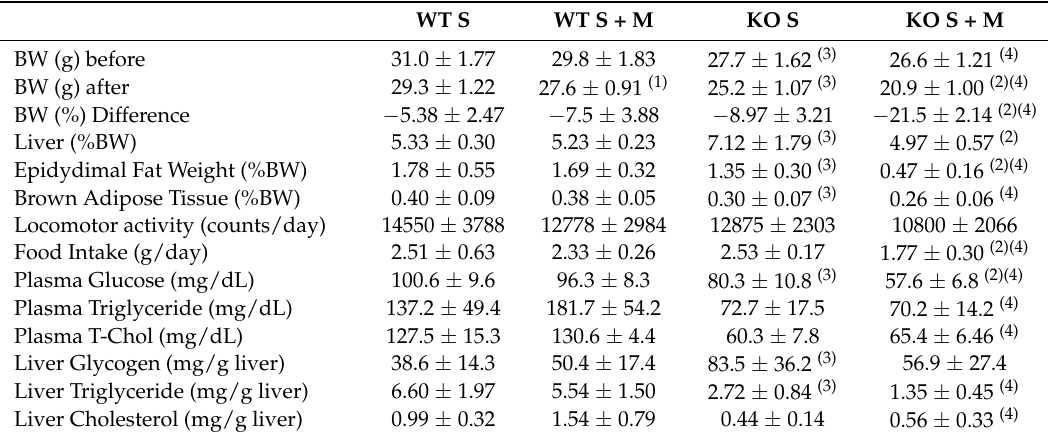
Table 1. The effect of 30% sucrose and 0.08% miglitol diet on wild-type mice and ChREBP knockout mice.